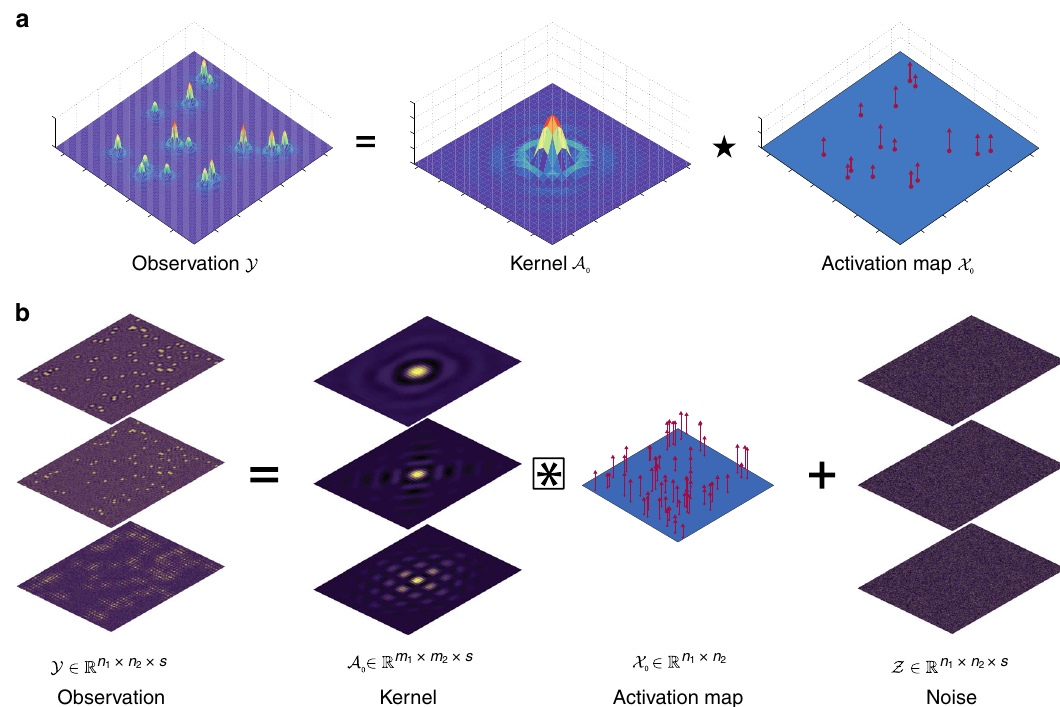
Fig. 2 Convolutional data model for STM. a Schematic representation of the convolutional data model Y ¼ A 0 ? X 0 for a noise-free simulated STM measurement. b Schematic representation of STM analysis as a high-dimensional deconvolution problem. Each constant-energy plane of A 0 is convolved with the known activation map X 0 and combined with additive noise Z to produce the noisy observation Y . Algorithms for SBD seek to ef fi ciently estimate A 0 and X 0 given the noisy measurement Y